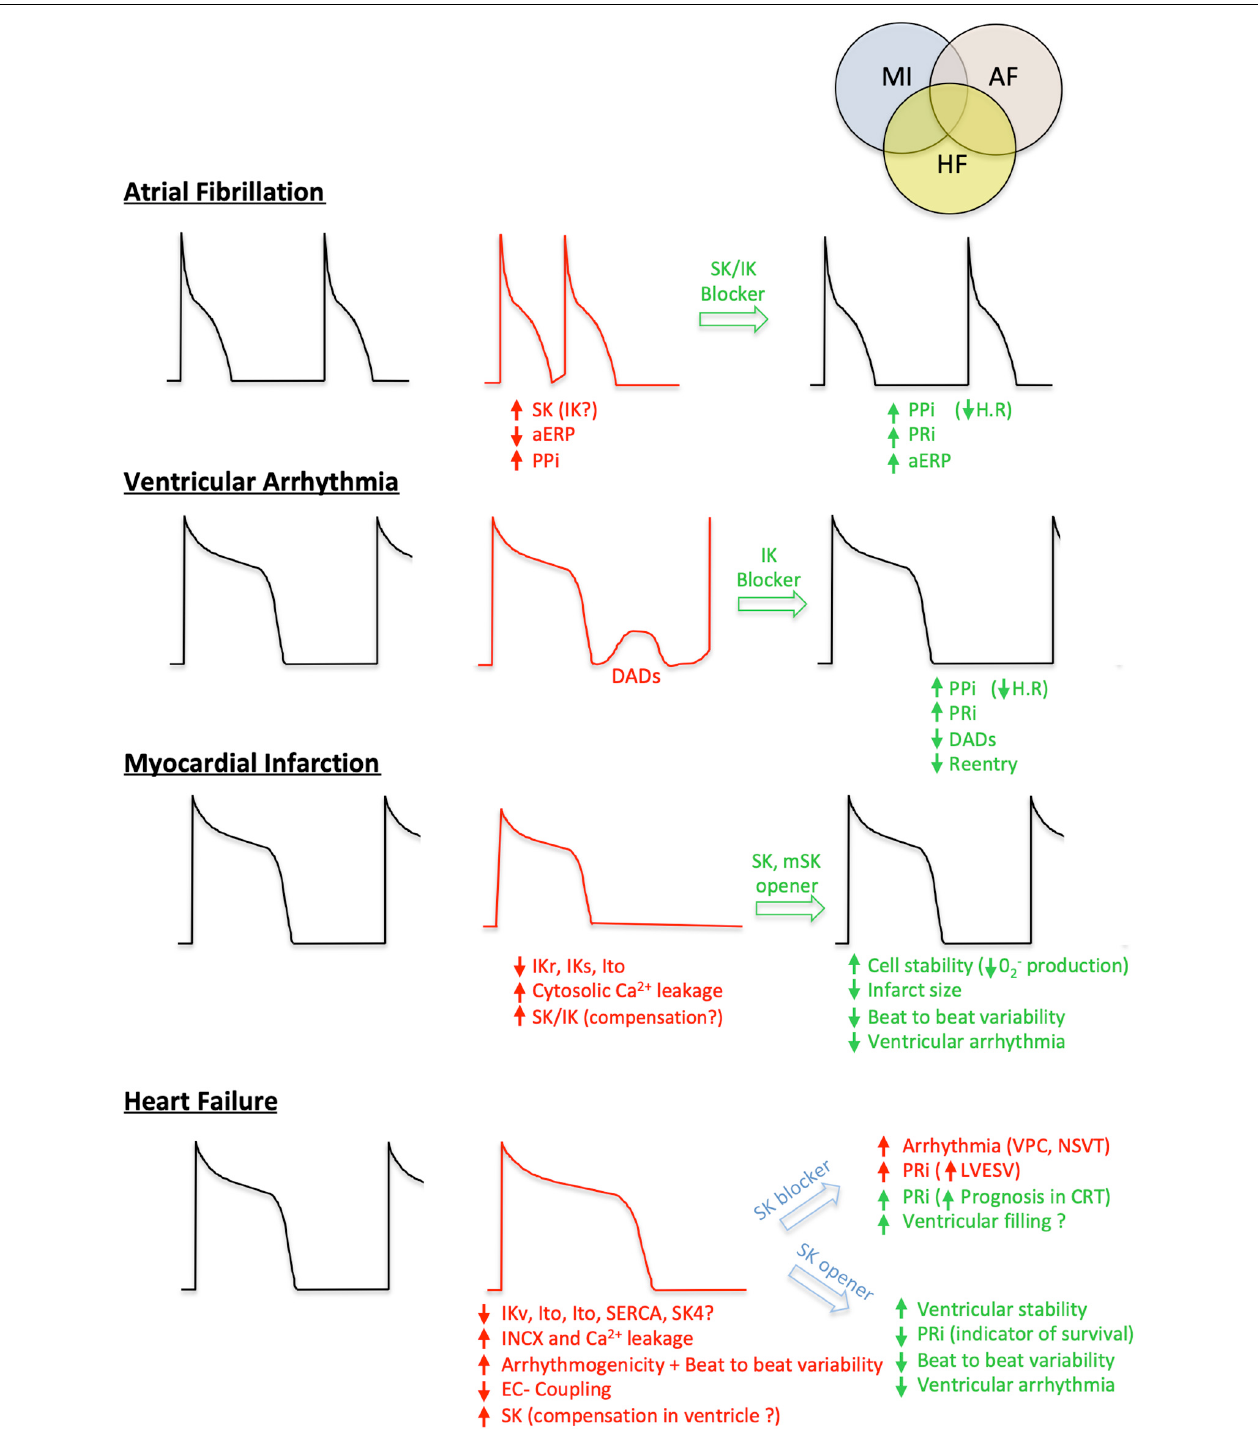
FIGURE 3 | Involvement of IK and SK in cardiovascular diseases and potential therapeutic strategies. For each condition (early stage Atrial Fibrillation, Ventricular arrhythmia, Myocardial Infarction and Heart Failure), a healthy action potential is shown (black cartoon) in comparison with the altered one (red cartoon). The different positive (green) or negative (red) effects based on ISKCa and IKCa modulations are summarized. PPi, P wave Interval; aERP, atrial effective refractory period; PRi, P-R segment; H.R, heart rate; DADs, delayed after depolarization; VPC, ventricular premature contraction; NSVT, non-sustained ventricular tachycardia; LVESV, left ventricular end-systolic volume; CRT, cardiac resynchronization therapy; IKr, rapid activating delayed rectifier potassium current; IKs, slow activating delayed rectifier potassium current; Ito, voltage-gated transient outward potassium current; INCX, sodium-calcium exchanger current.